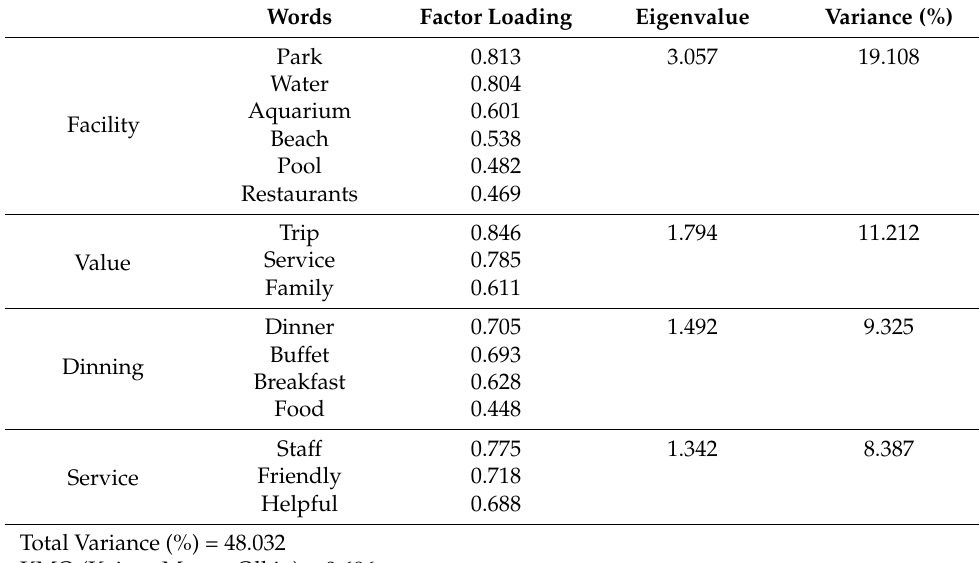
Table 4. Result of the factor analysis.